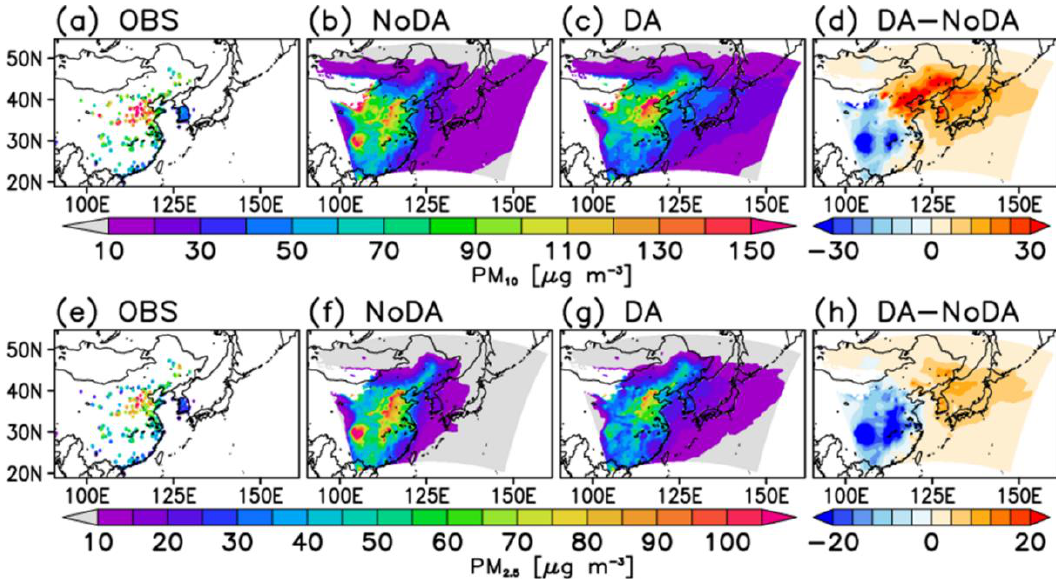
Figure 4. Seasonal average of surface PM concentration analysis at the lowest model level for ( a , e ) observation, ( b , f ) NoDA, and ( c , g ) DA experiments on Domain 1. ( d , h ) Differences in DA and NoDA experiments. The top row shows PM 10 , and the bottom row shows PM 2.5 . The desert region is masked out.